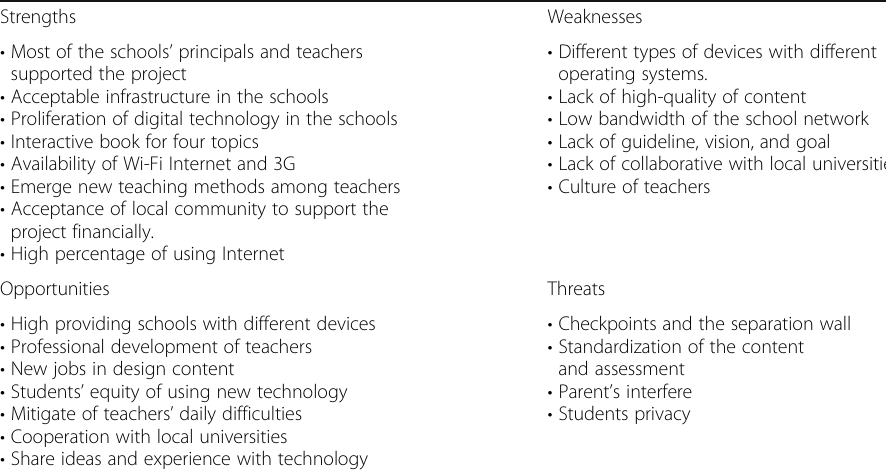
Table 1 Strengths, Weaknesses, Opportunities, and Threats of the SL project Strengths Weaknesses